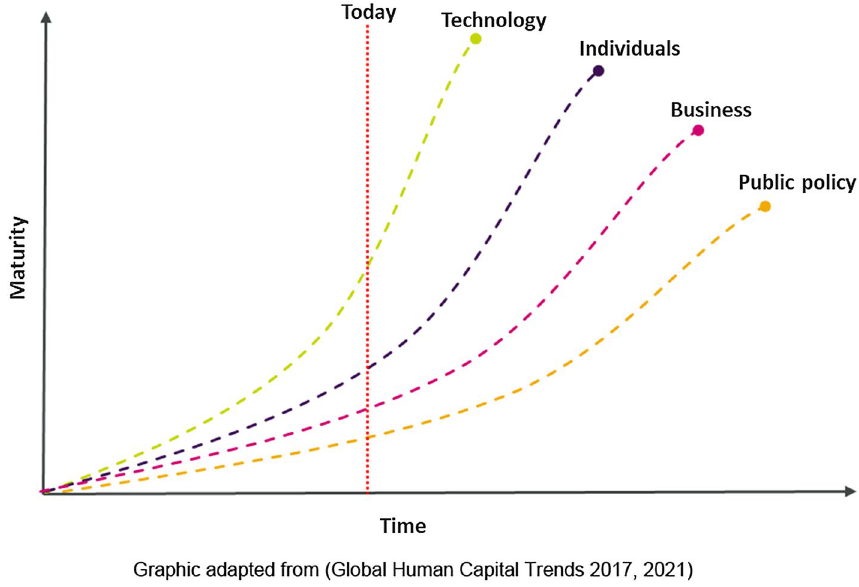
Fig. 5 The maturity and time for the full adoption of synthetic data, with technol- ogy, individuals, business